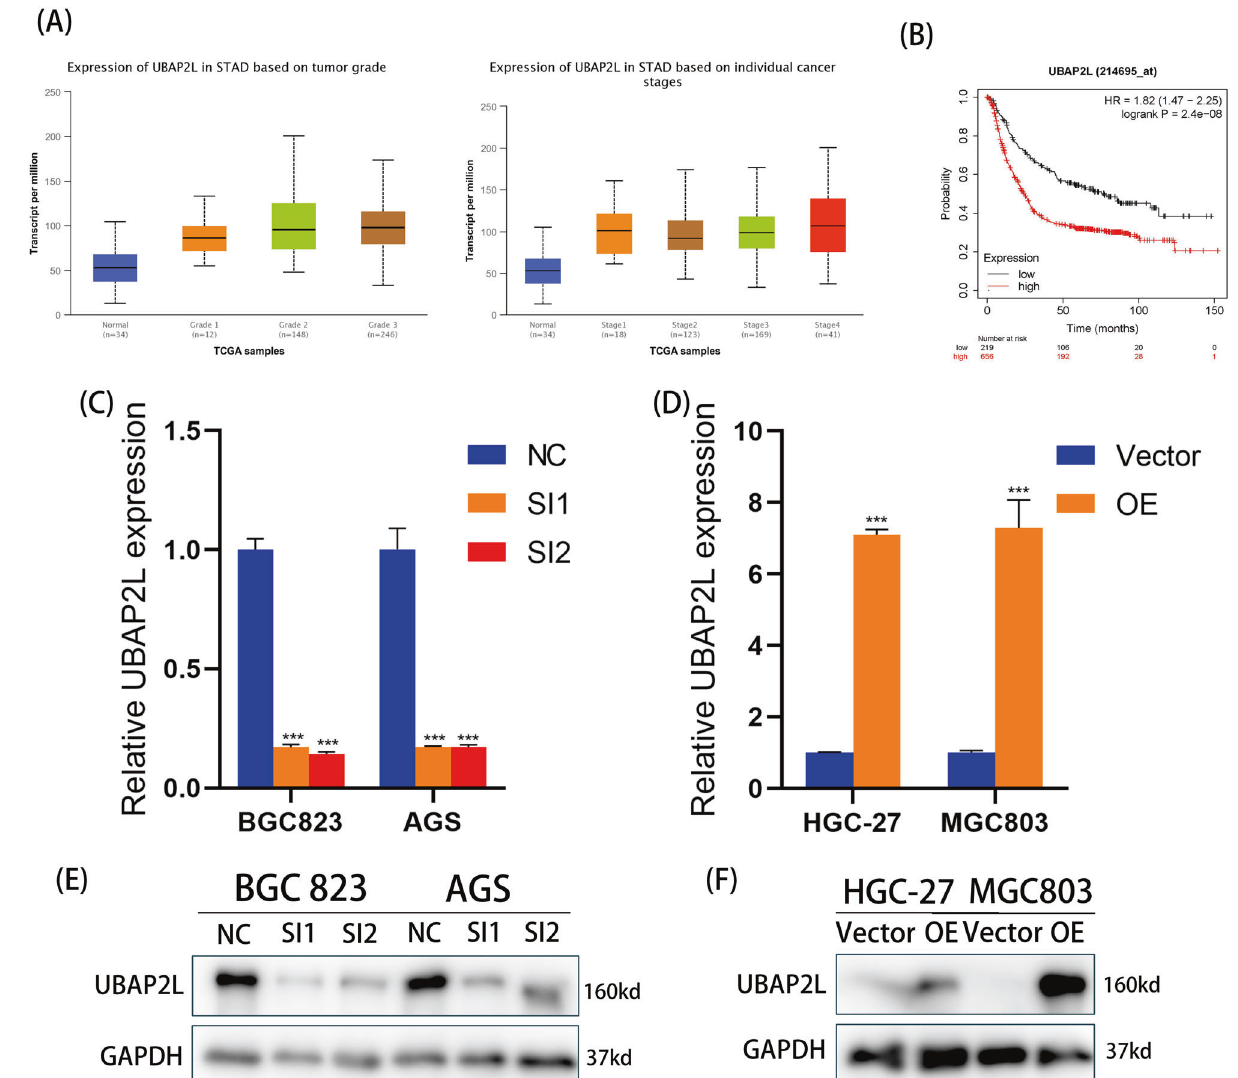
Fig. 2 Relationship between UBAP2L and prognosis and validation of knockdown and overexpression. A The expression of UBAP2L in individual tumor grades and GC stages based on UALCAN database. B Overall survival (OS) of GC patients based on UBAP2L expression using Kaplan – Meier Plotter website. C – F The ef fi ciency of UBAP2L silence in BGC823 and AGS cell lines and overexpression in HGC-27 and MGC803 cell